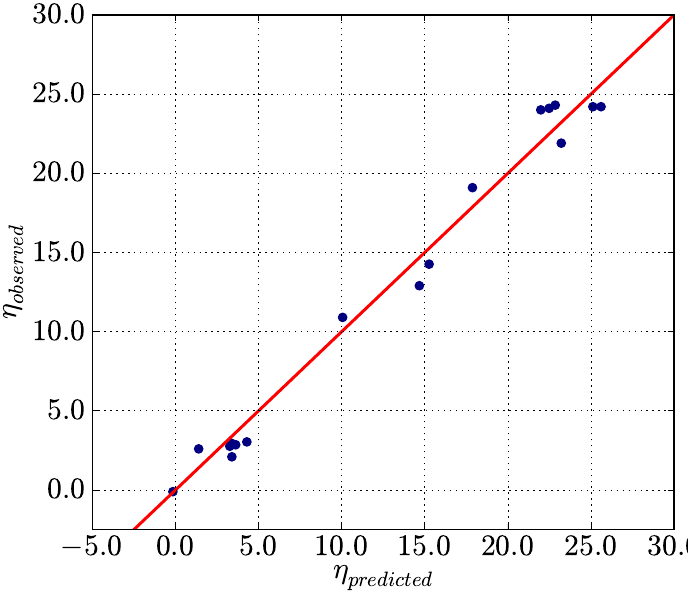
Figure 3. Prediction of the screening design. R 2 = 0.98.